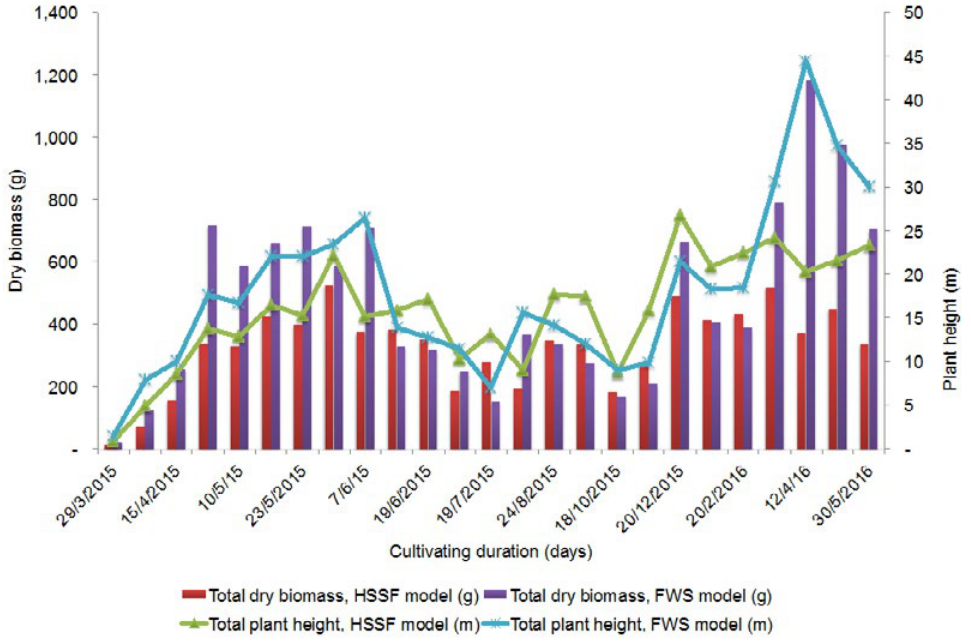
Fig. 3: Dry biomass and total height of Cannas generalis in the hybrid